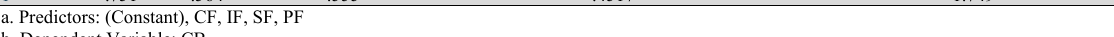
Regression analysis with Enter method Model Summary b